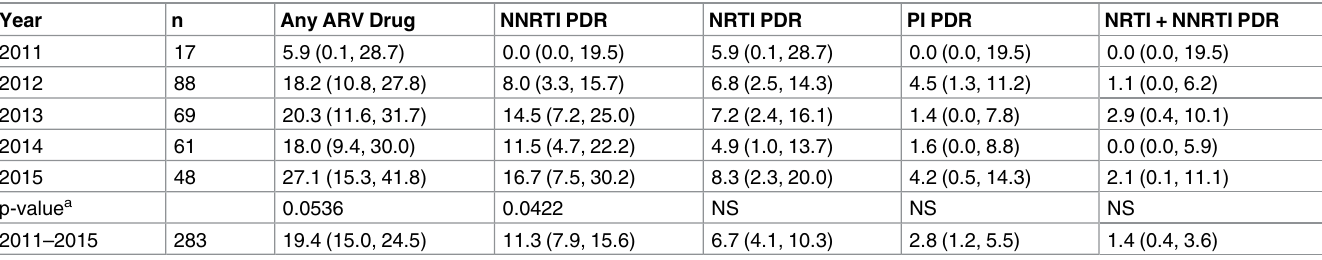
Table 3. HIV pre-treatment drug resistanceby year of enrolment.